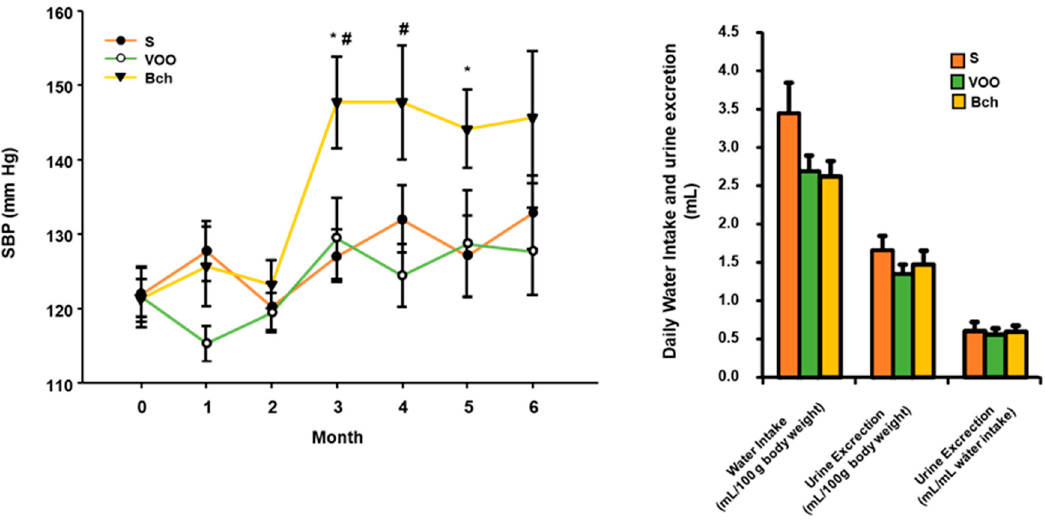
Figure 1. Means values ± standard errors of systolic blood pressure (SBP) expressed as mmHg, water intake and urine excretion, expressed as mL/100 g BW and the relationship between urine excretion and water intake. S: standard diet, VOO: virgin olive oil diet, Bch: butter plus cholesterol diet. * indicates significant differences between VOO or Bch vs. S, * p < 0.05. # indicates significant differences between VOO and Bch, # p < 0.05.